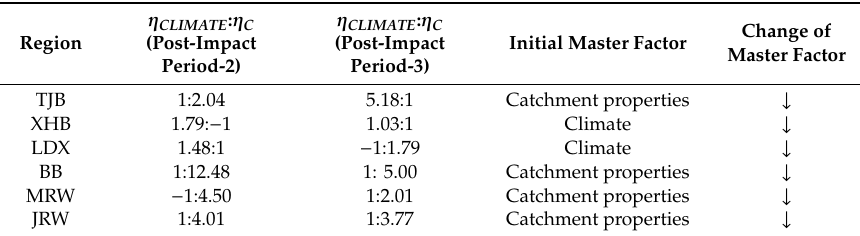
Table 4. Contribution variation in two post-impacted